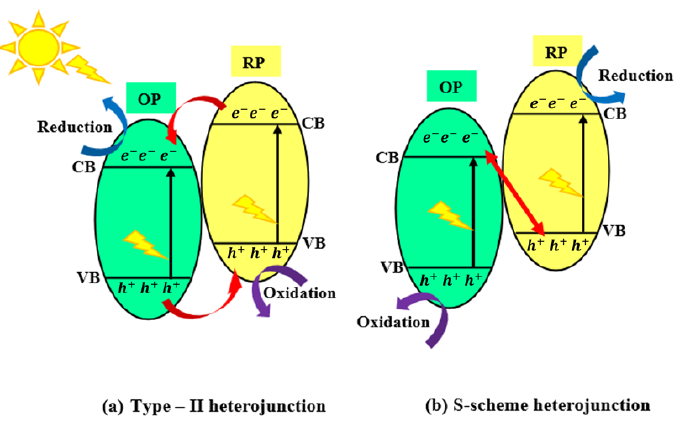
Figure 18. Schematic illustration of ( a ) Type II heterojunction and ( b ) S-scheme heterojunction. The S-configuration for the heterojunction allows for increased efficiency through high internal electric fields, bending of bands, and increased Coulomb attraction. These increase the driving force, allowing for the recombination of electrons in the CB of OP and hole rearrangement in the VB of RP. Therefore, the unproductive electrons and holes are successfully excluded through recombination, and the productive electrons and holes are retained to be enrolled in photocatalytic reactions. Figure 19 shows the development of these three main factors: (a) As seen in Figure 19a, RP has higher CB and VB band posi- tions and lower work function than OP; when these two semiconductors are close to each other (before contact), the electrons of RP transfer to OP, thus creating an electron deple- tion and electron accumulation layer adjacent to the interface. Concurrently, the nega- tively charged OP and positively charged RP produce an internal electric field directed from RP to OP; Figure 19b. This produced electric field effectively accelerates the transfer of photogenerated electrons from OP to RP. (b) When OP and RP are connected, their relative Fermi levels should also be aligned, inducing an upward and downward shift in the Fermi levels of OP and RP. In this regard, the band bending forced the accumulated photogenerated species at the interface region (electrons in the CB of OP and holes in the VB of RP) to be recombined. (c) Due to Coulombic attraction between holes and electrons, holes in the VB of RP and electrons in the CB of OP are tilted and inclined to recombine at the interface [75–77]. It should be noted that S-scheme photocatalysts have numerous ap- plications in different fields such as hydrogen production [78–80], disinfection against bacteria [81,82], and pollutant degradation [83,84]. The S-scheme charge transfer mecha- nism of TiO 2 and PDA, before, after, and under irradiation during CO 2 reduction is shown in Figure 20 [77,78]. The effect of potential discontinuity in bands, and the overlapping of bands in three different heterojunctions, is shown in Figure 21. As shown, charge carriers’ movement between the band levels of Type II heterojunctions maintains the specific charge separation. According to the number of connected semiconductors, heterojunc- tions can be classified into binary, ternary, and quaternary heterojunctions [79].